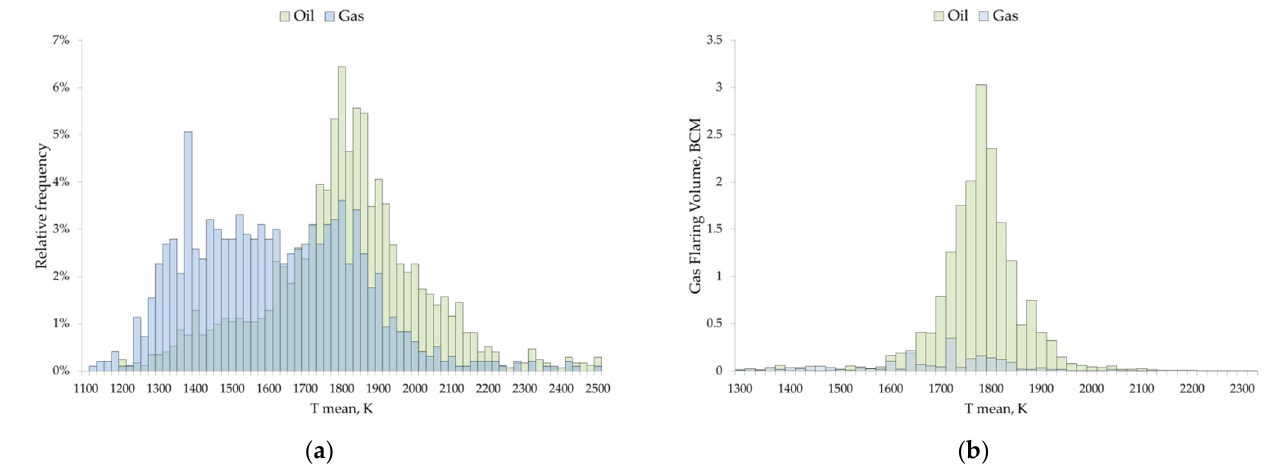
Figure 11. ( a ) VIIRS Nightfire gas flares’ mean temperature (in K) relative frequency distribution in Russia for gas flares located at oil and natural gas/gas condensate upstream facilities. Relative frequencies are calculated independently. ( b ) Gas flaring volume (in BCM) distribution by mean temperature (in K).